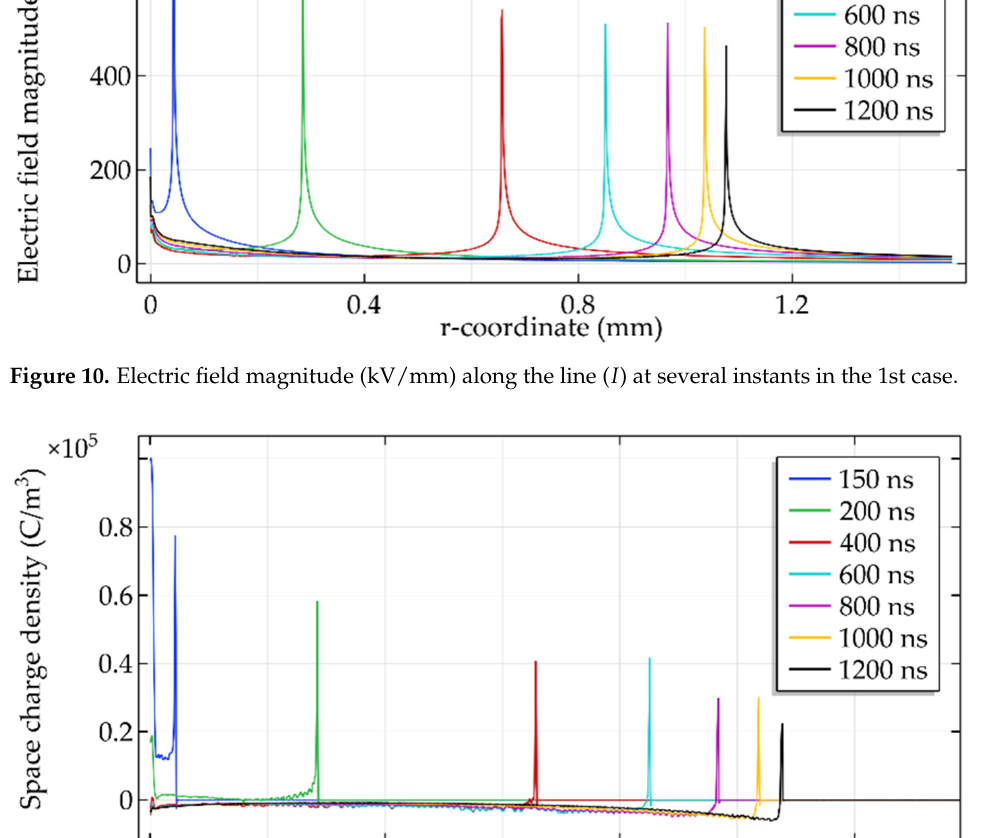
Figure 11. Space charge density (C/m 2 ) along the line ( 𝐼 ) at several instants in the 1st case.